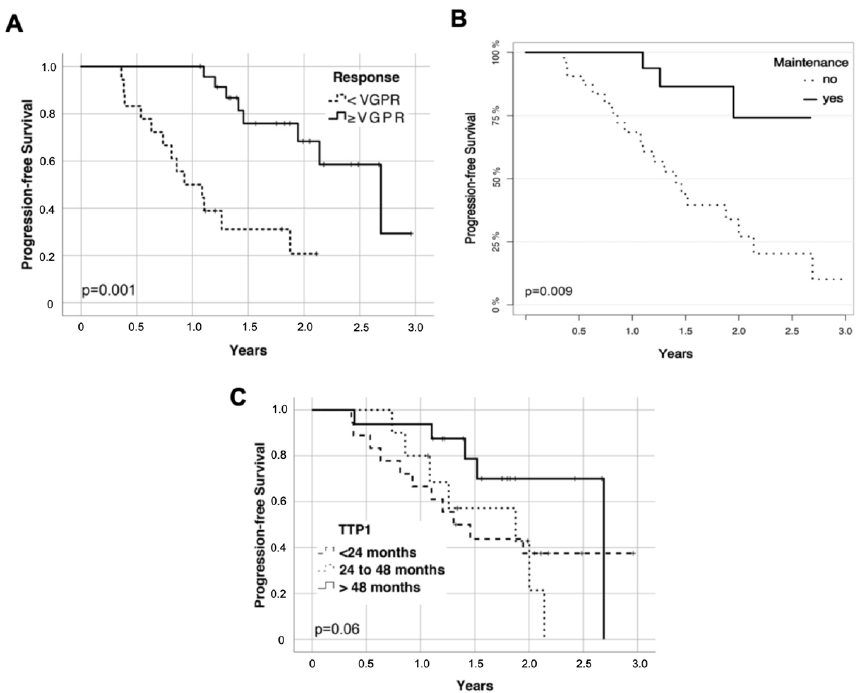
Figure 4. Progression-free survival (PFS) according to ( A ), Kaplan – Meier plot response at the time of salvage HDCT/ASCT, ( B ), Simon – Makuch plot maintenance treatment after salvage HDCT/ASCT, and ( C ), Kaplan – Meier plot time to progression after frontline HDCT/ASCT (TTP1) PFS was calculated from salvage ASCT. Table 3. Multivariate Cox regression analysis of prognostic impact on progression free survival (PFS) from salvage HDCT/ASCT.